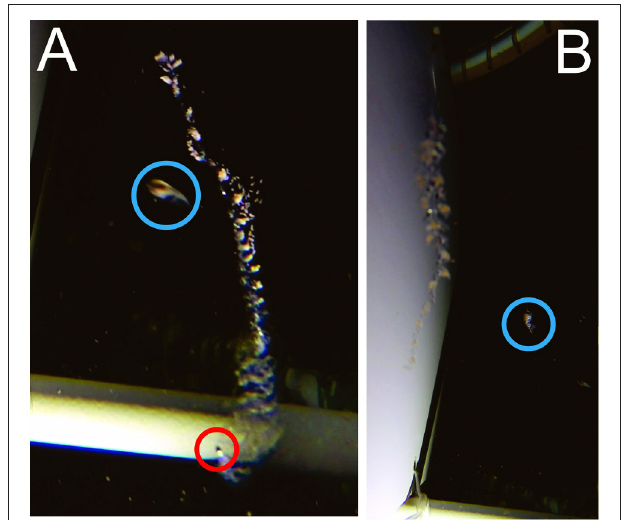
FIGURE 7 | Still photos from the GoPro video recordings at 265m depth in Lyngenfjord on 9 November 2015 (cf. Figure 1), showing most probably physonect siphonopohores. (A) Specimen with pneumatophore encircled (red ring) and an amphipod (cyan ring). (B) Siphonophore with an amphipod encircled (cyan ring) to indicate size difference between the two. The amphipod could be of the genus Themisto and ∼ 2–3cm in total length. Note the pinkish to orange coloration of the gastrozooids and/or gonophores. The white bar at the bottom of both images and at the top of (B) are parts of the Seabird CTD frame. According to Seabird the distance between upper and lower part of this frame is 82.5cm. See http://www.seabird.com/sbe32-